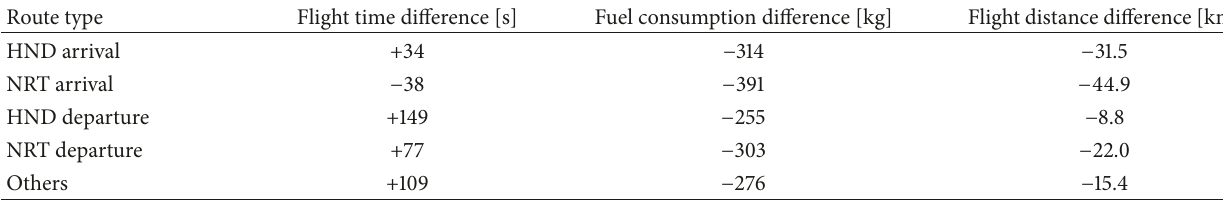
Table 5: Average of difference values for each route type (Type-A).